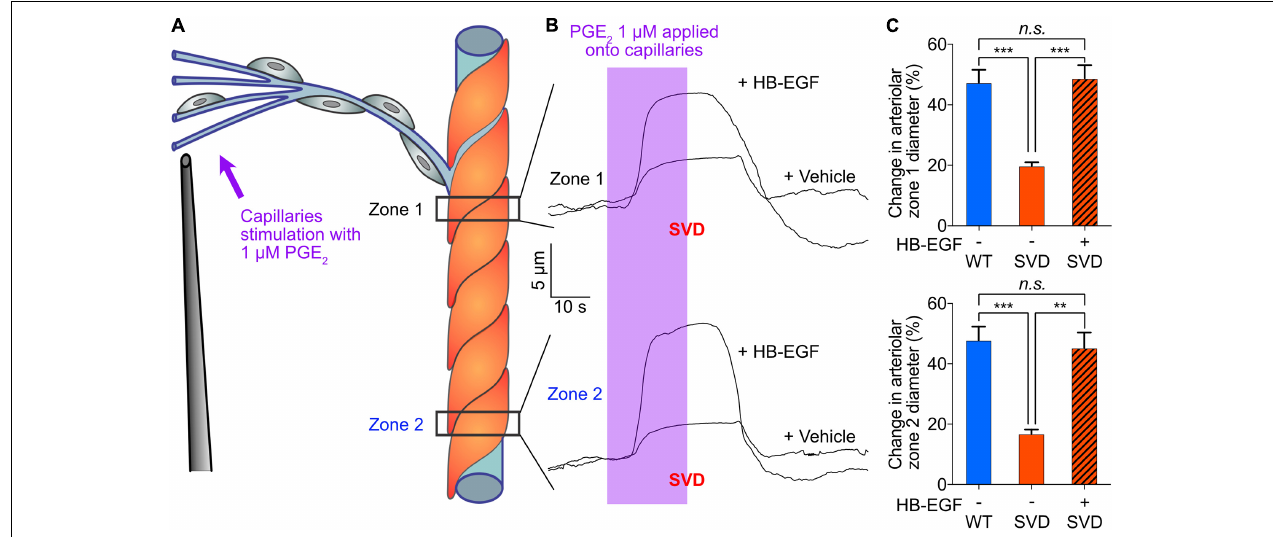
FIGURE 5 | In the SVD mouse model, blunted upstream arteriolar dilation in response to capillary stimulation with PGE 2 is completely restored by bath application of 30 ng/ml HB-EGF. (A) Cartoon showing Zone 1 and Zone 2 positions for arteriolar diameter recording during capillaries stimulation with 1 µ M PGE2. (B) Representative traces of arteriolar diameter showing the effect of pressure ejection of PGE 2 1 µ M onto capillaries in absence or presence of 30 ng/ml HB-EGF in a preparation from SVD mouse model. (C) Summary data from 5 to 6 mice ( n.s. , not significant; ** P < 0.01, *** P < 0.001, one-way ANOVA Dunnett’s test).